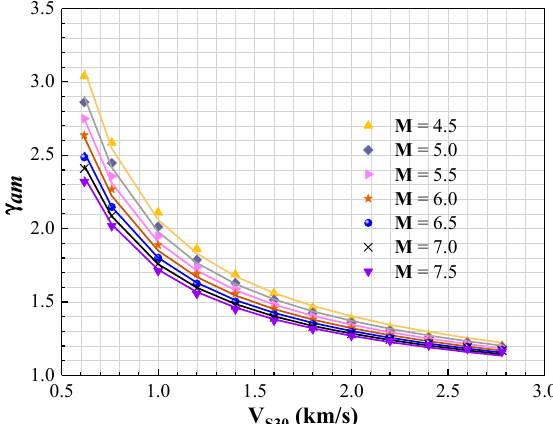
Figure 6. Regression analysis results of upper crustal amplification factor ( γ am ).